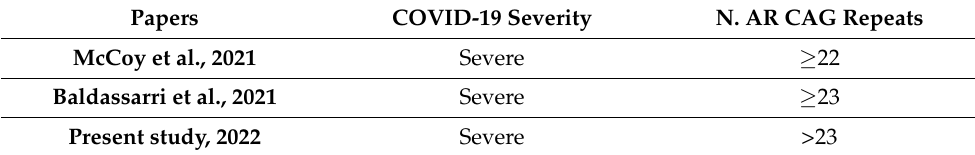
Table 3. Comparison of the results of this study with the results of published